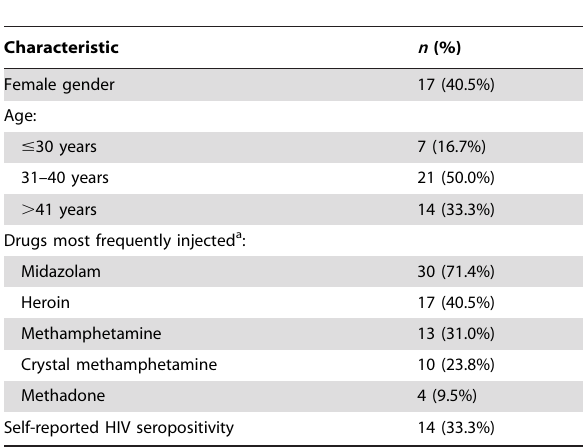
Table 1. Sample characteristics ( n